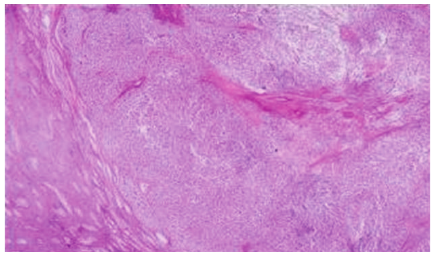
Figure 2: Seminoma of the left testis.